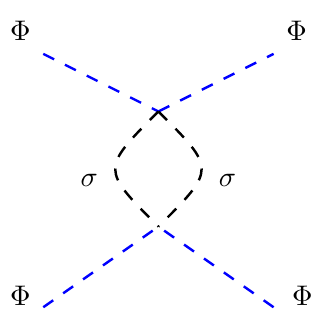
Figure 7 . One-loop correction to the Φ quartic coupling due to its interaction with the singlet σ that drives spontaneous lepton number violation in inverse seesaw models. This diagram leads to a “positive” term in the RGE of the Φ quartic coupling, that can overcome the destabilizing effect of the fermions in figure